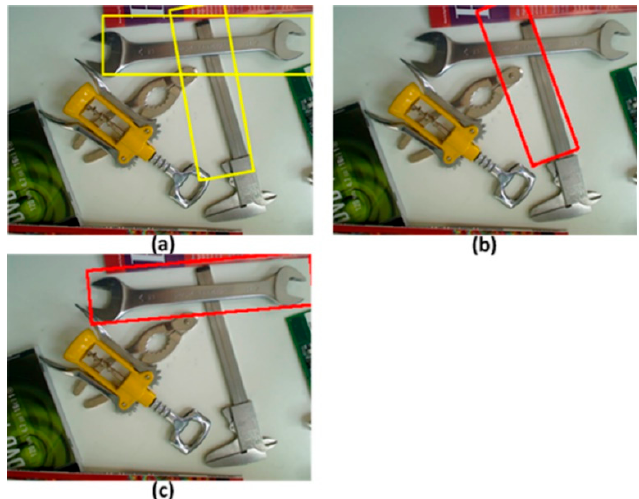
recognition by using the weight of model as displayed in Figure 6b.